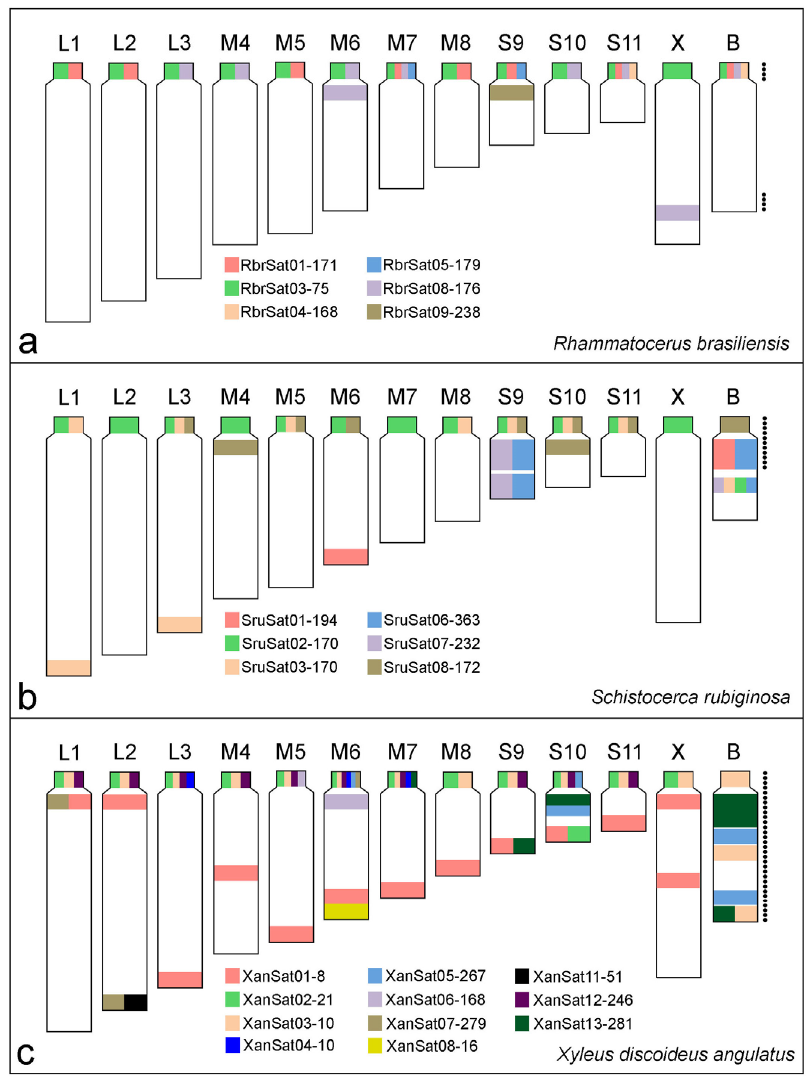
Figure 5. Ideograms summarizing the chromosomal location of clustered satDNAs in the three species of grasshoppers, ( a ) R. brasiliensis , ( b ) S. rubiginosa , and ( c ) X. d. angulatus . Each satDNA family is represented by one color. Black dots next to the B chromosomes indicate heterochromatin distribution in these chromosomes.